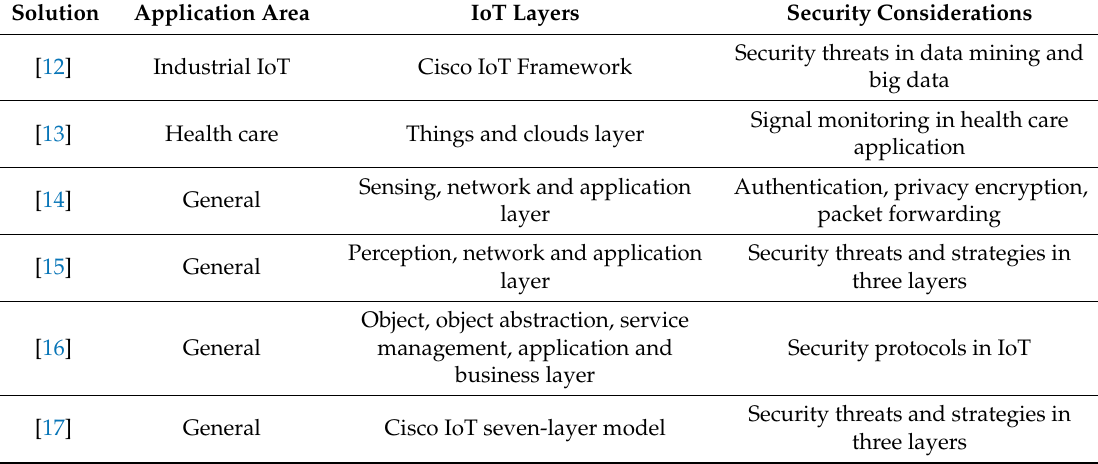
Table 1. A summary of security considerations for IoT